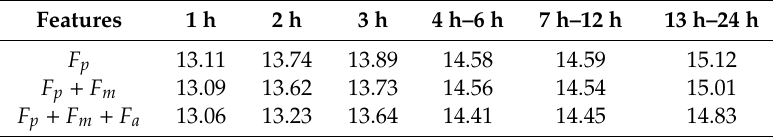
Table 5. The root-mean-square error (RMSE) of various features in AC-LSTM.